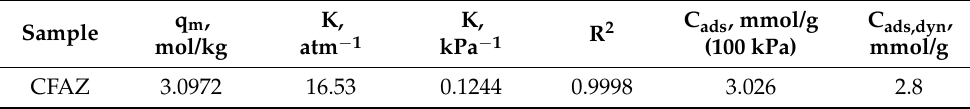
Table 2. Langmuir model parameters of CO 2 adsorption onto